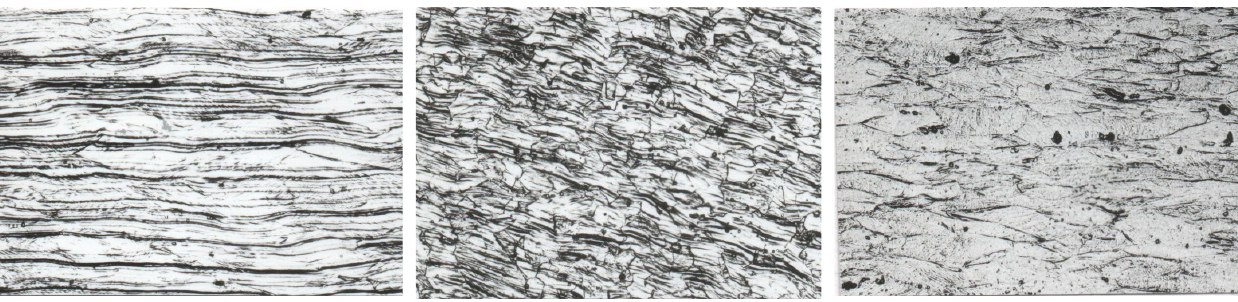
Figure 4c: “4L” steel microstructure – Radial section (x 200).